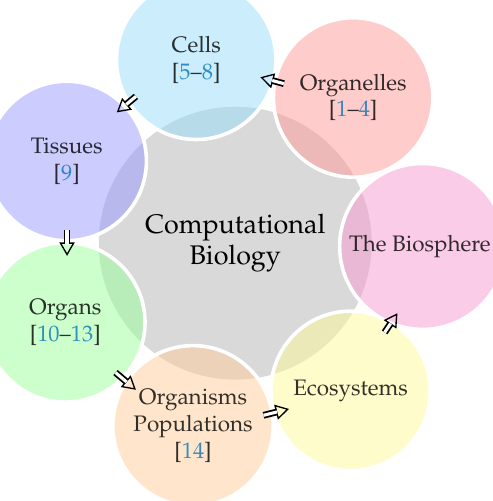
Figure 1. From a single organelle to the entire biosphere, living organisms are parts of a highly structured hierarchy.